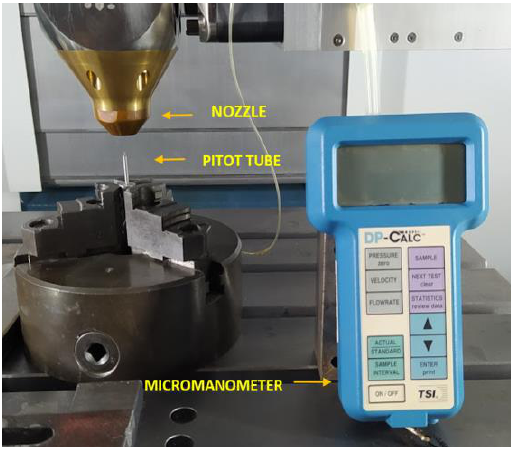
Figure 4: Setup experimental